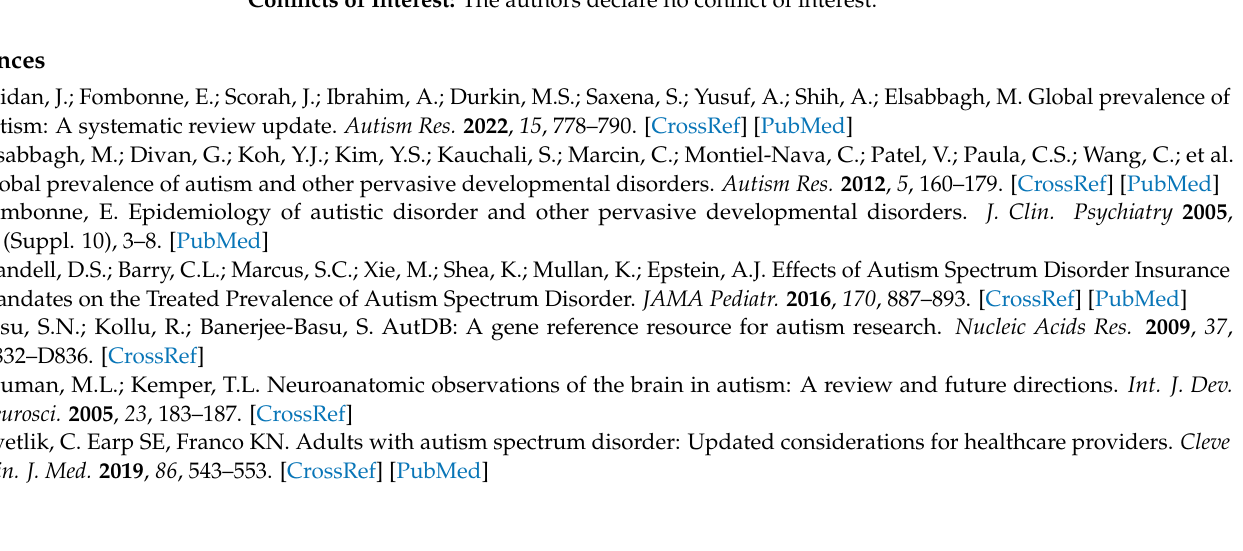
Table S2. Predicted target genes of miR-15b-5p using miRDB; Table S3. Functional annotation of biological process using miR-15b-5p target genes; Table S4. Expressional differences based on age and gender (discovery and replication cohorts: n = 26,